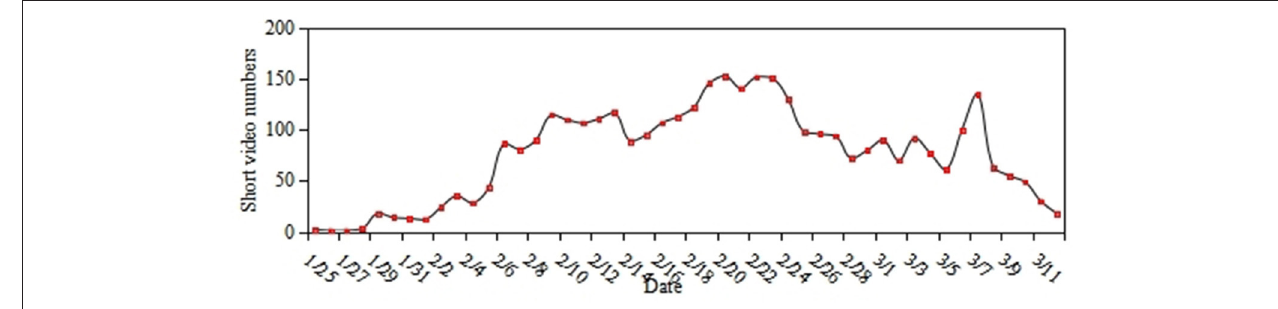
FIGURE 6 | Changes in release time of short fitness videos on TikTok.